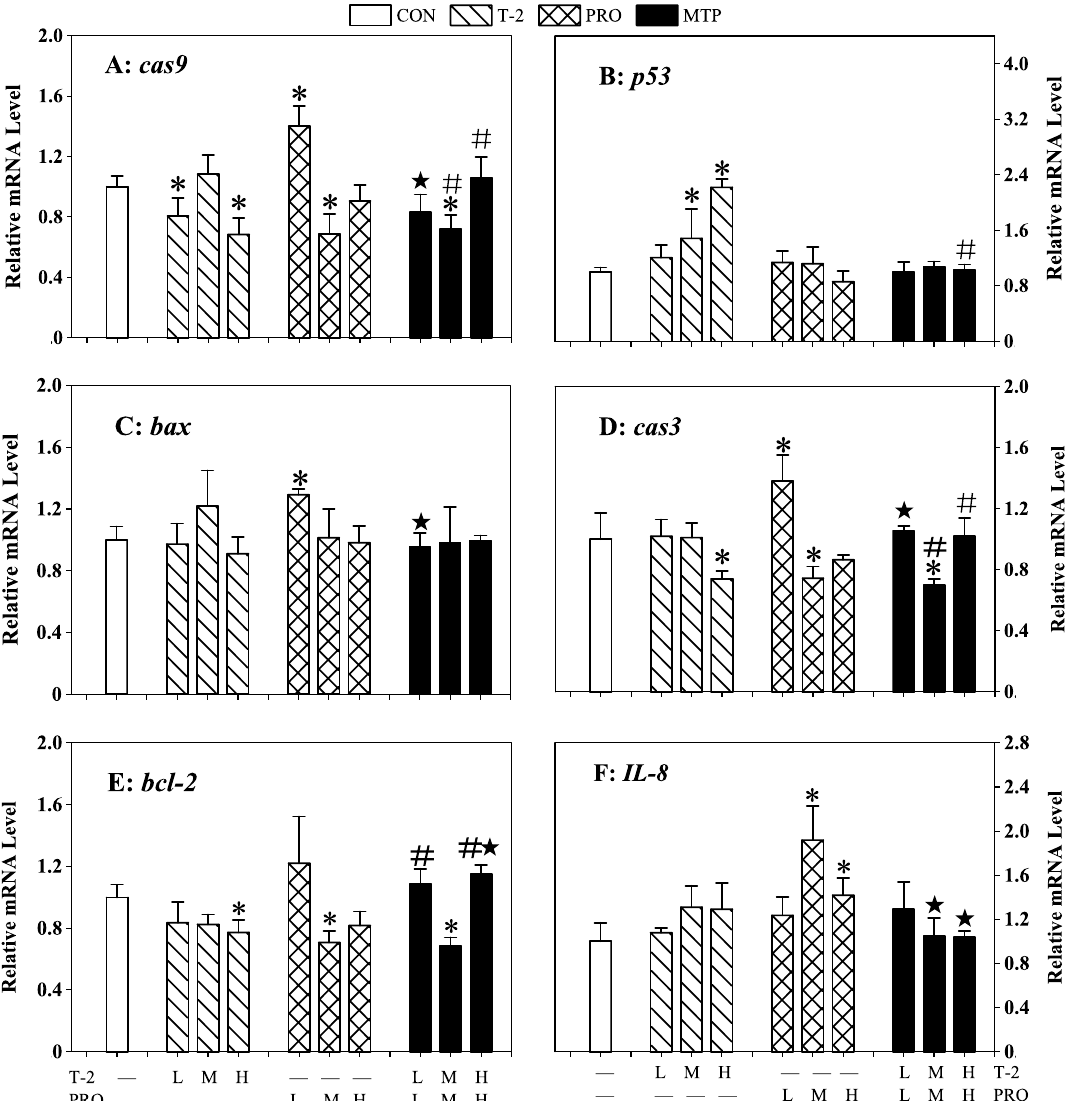
Fig. 5 Influences upon expressions of genes involved in the apoptosis and immune-related of fish administrated with T-2 PRO and their combinations. A cas9 , B p53 , C bax , D cas3 , E bcl-2 , F IL-8 . Each bar represents the mean a group of 50 fish). * p < 0.05 substantial alteration by comparison with the control; # p < 0.05 significant difference relative to the corresponding T-2 exposure; ★ p < 0.05 significant difference relative to the corresponding PRO exposure. CON control, T-2 T-2 toxin, PRO propiconazole; MTP the mixture of T-2 and PRO. L low concentration, M middle concentration, H high